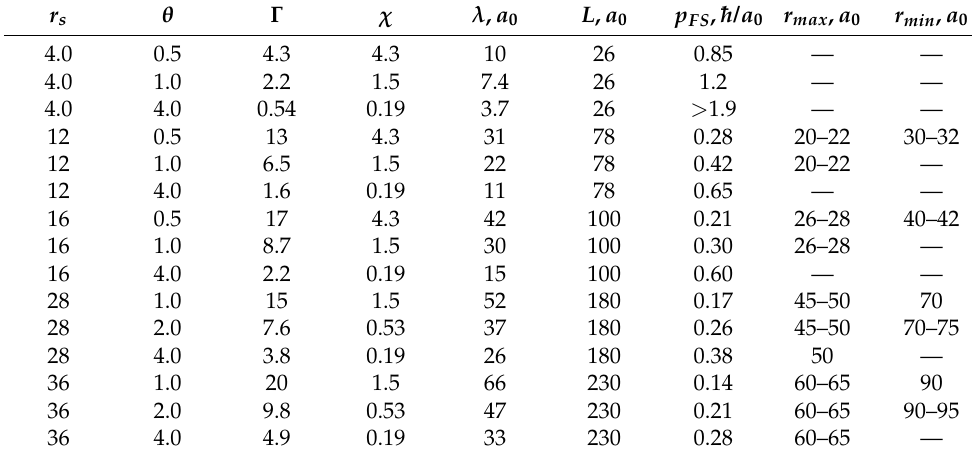
Table 1. Some parameters and data describing the MDFs and PCFs from the Figures 1–5. The values are shown with two significant